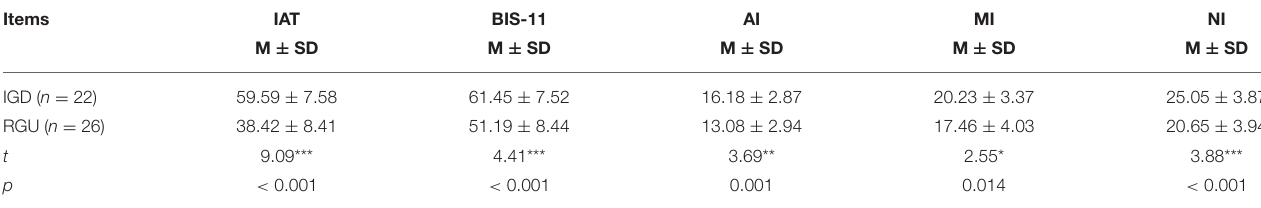
TABLE 2 | Correlation analysis of IAT and BIS-11.